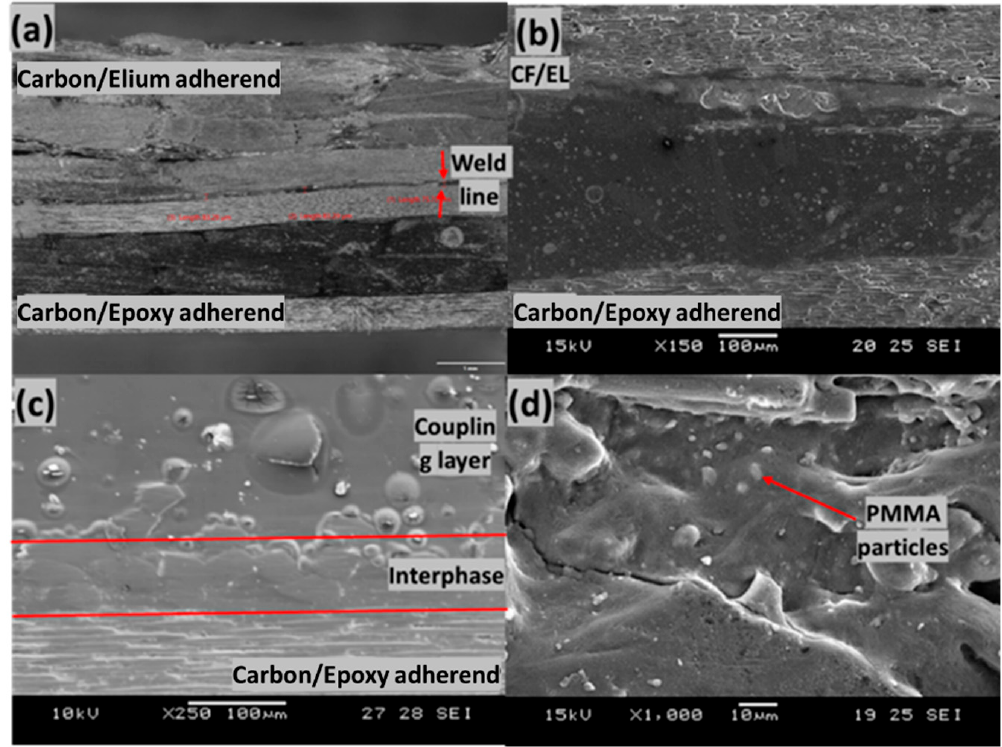
Figure 16. Cross-section of EL-EP(Elium ® -Epoxy)_0.25. ( a ) Overall view, ( b ) Scanning Electron Microscope of welded interface, ( c ) top layer of unwelded epoxy adherend, ( d ) top layer of welded epoxy adherend.